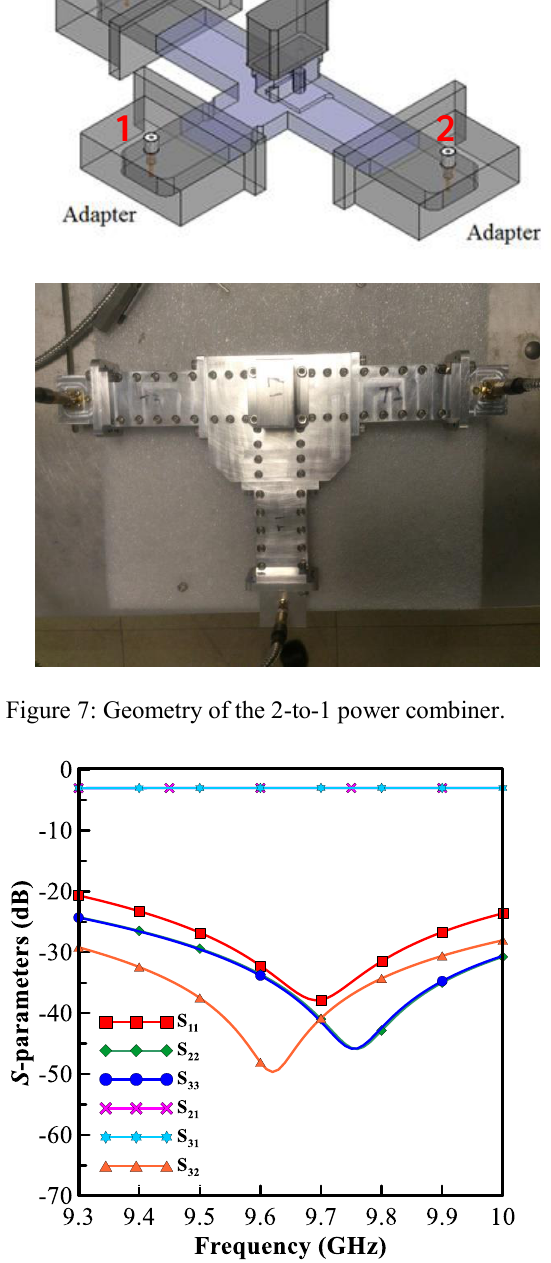
Figure 8: Simulated results of the 2-to-1 power combiner with three SMA-to-waveguide adapters.